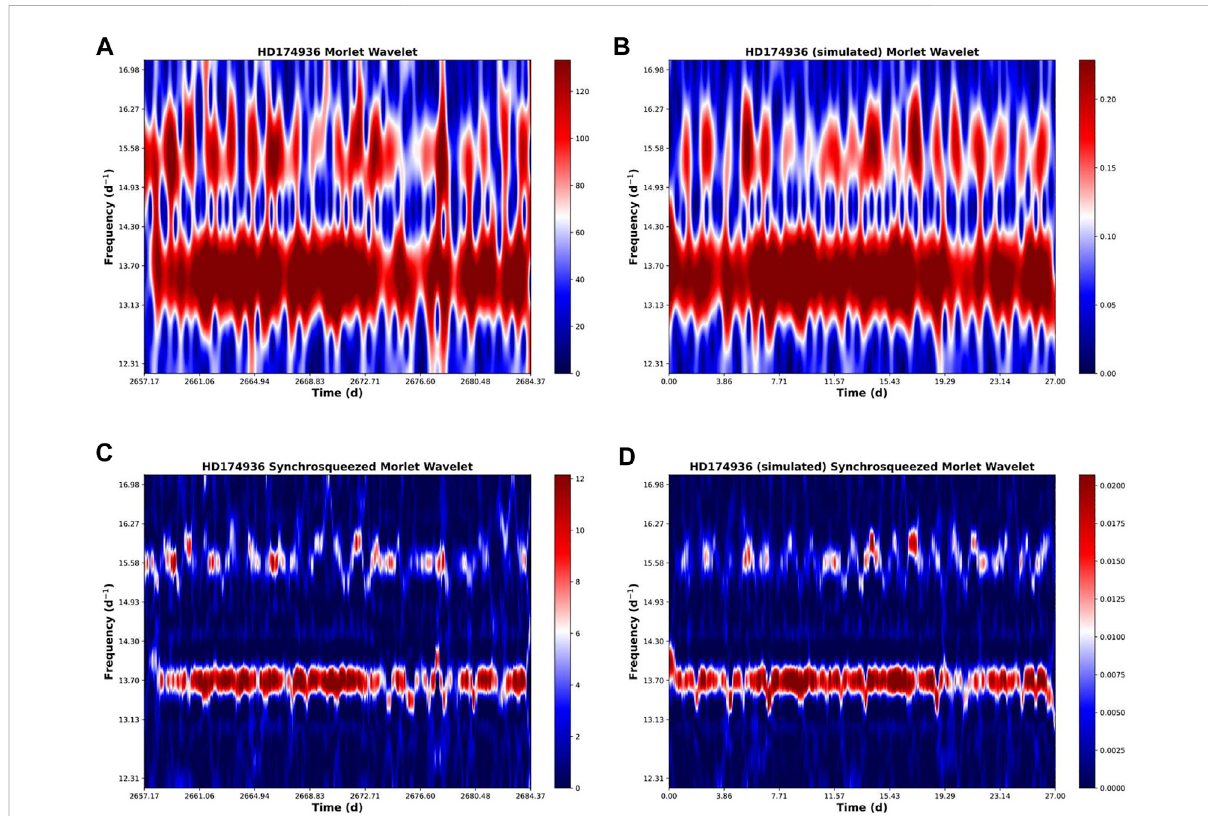
FIGURE 2 Main pulsation frequencies of HD174936. The similar behaviour of the frequencies at 13.70 and 15.58 d − 1 found in the analysis of both the real and thesynthetic datacan beusedto con fi rm thatthefrequencies found inthelightcurvearestationary.The CWTof bothfrequenciesshown seem